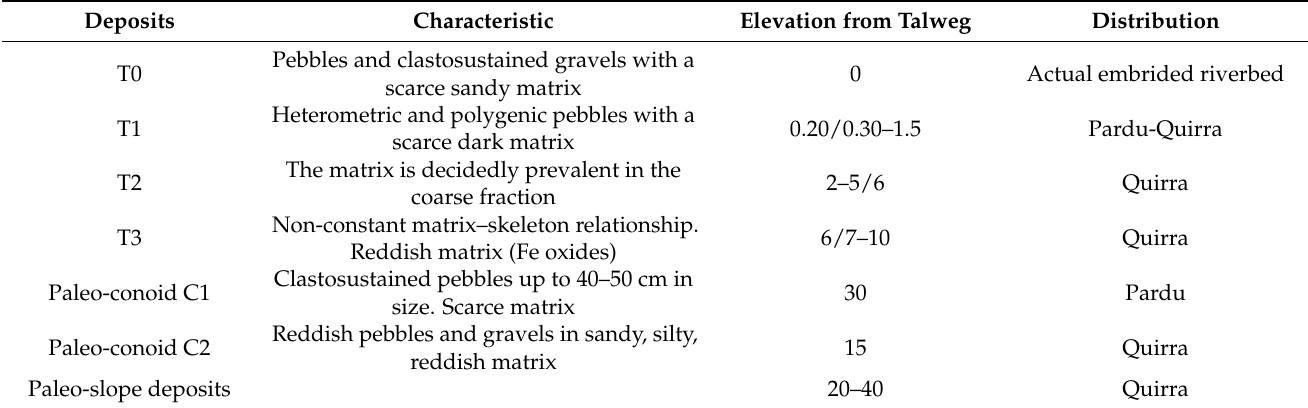
Table 3. Morphostratigraphic